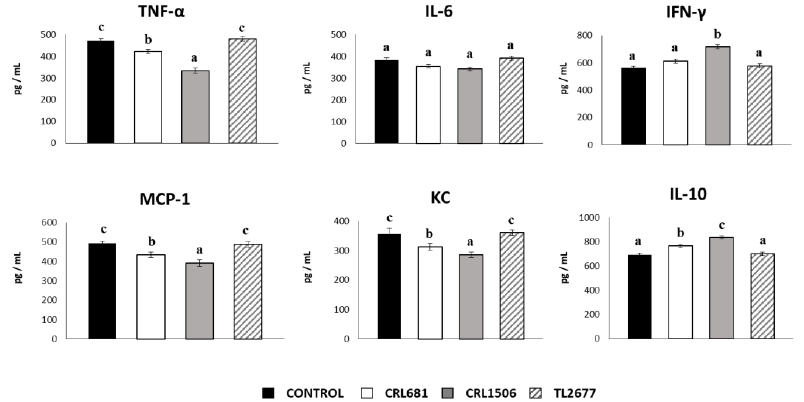
Figure 8. Immunomodulatory effect of Lactiplantibacillus plantarum CRL681, CRL1506 or TL2677 in mice in response to enterotoxigenic Escherichia coli (ETEC) challenge. Mice were orally treated with L. plantarum CRL681, CRL1506 or TL2677 (10 8 cells/mouse per day for 5 consecutive days) and then challenged orally with ETEC F4 strain (10 9 cells). Mice with no lactobacilli treatment and challenged